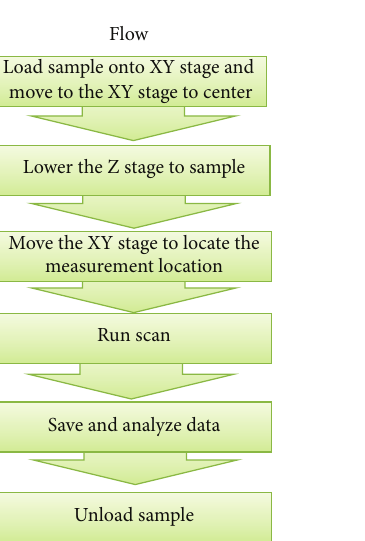
Figure 11: The scan curve.